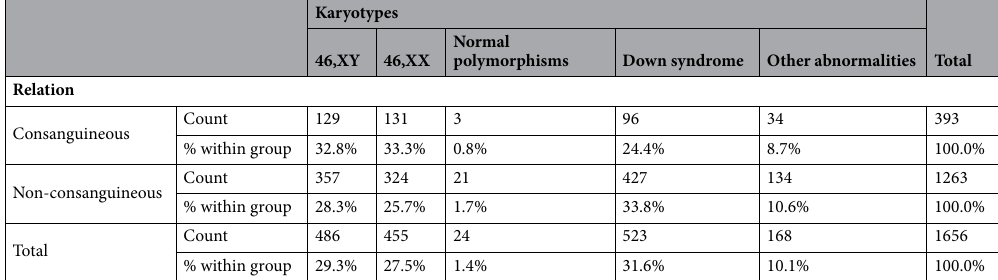
Table 7. Distribution of different karyotypes among consanguineous and non-consanguineous marriages.